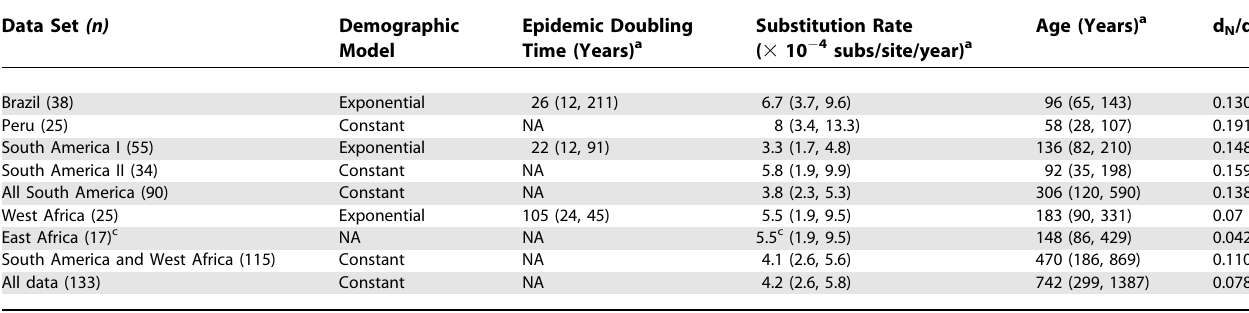
Table 2. Evolutionary Rates and Divergence Times of Yellow Fever Viruses Data Set (n)